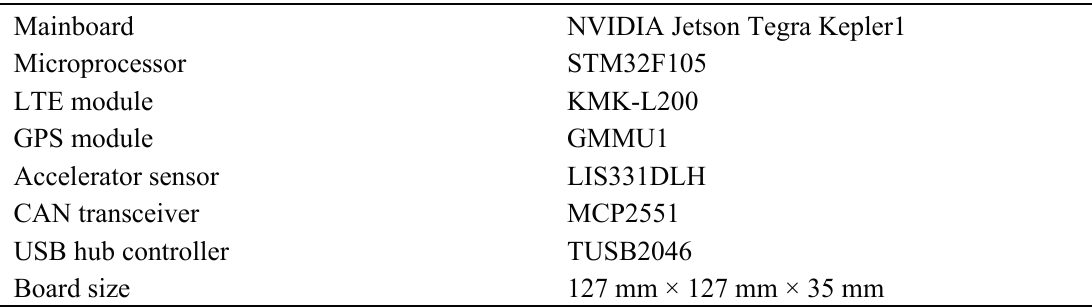
Table 4. Hardware specifications of smart vehicular